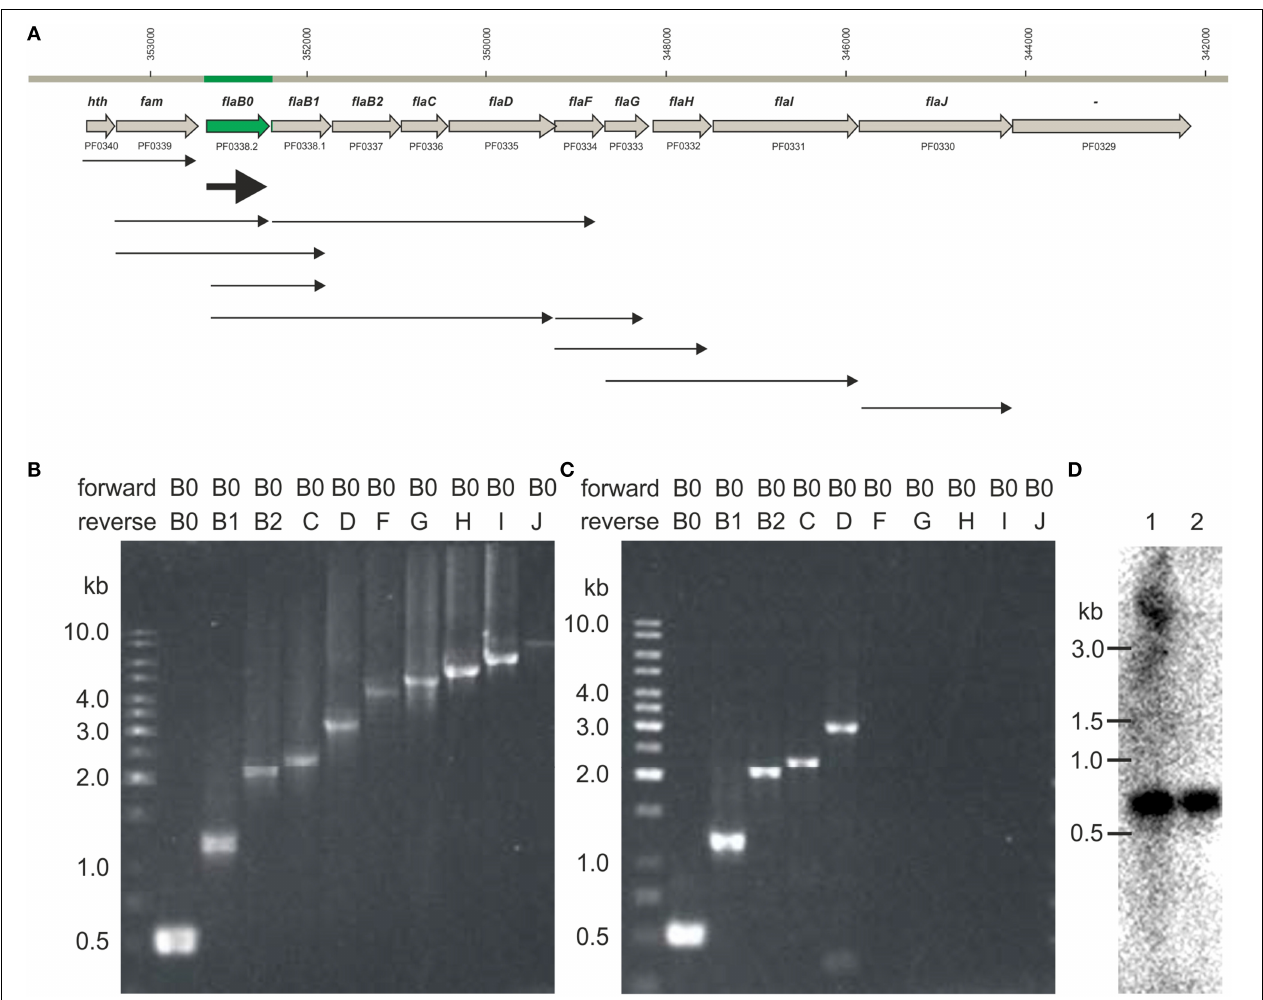
FIGURE 6 | Transcripts observed for the P. furiosus flagellar operon. (A) Flagellar operon of Pyrococcus furiosus with neighboring genes in the upper part. All genes are transcribed from the negatively oriented DNA strand, but are shown here from left to right for easier orientation. Arrows in the lower part indicate cotranscripts identified via RT-PCR. (B) PCR data using genomic DNA as positive control; forward primer was Pfu-flaB0_f, reverse primers were Pfu-flaB0_r to Pfu-flaJ_r. (C) PCR data